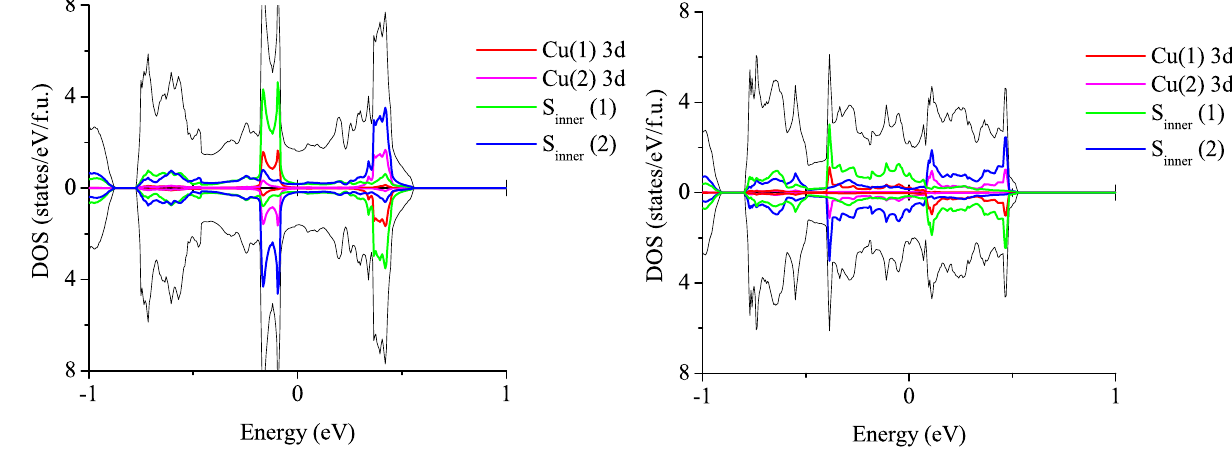
Figure 8. Electronic densities of states for antiferromagnetic Cu(tmdt) of (2 a ; b ; c ) (left) and ( a ; 2 b ; c ) (right) with partial densities of states from Cu 3d and four S atoms surrounding Cu (S ), respectively. The labels (1) and (2) distinguish two Cu atoms inner in the unit cell.